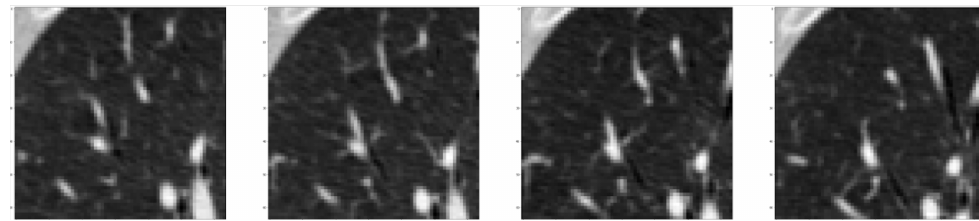
Figure 3. An example of a malignant lung nodule from the CT